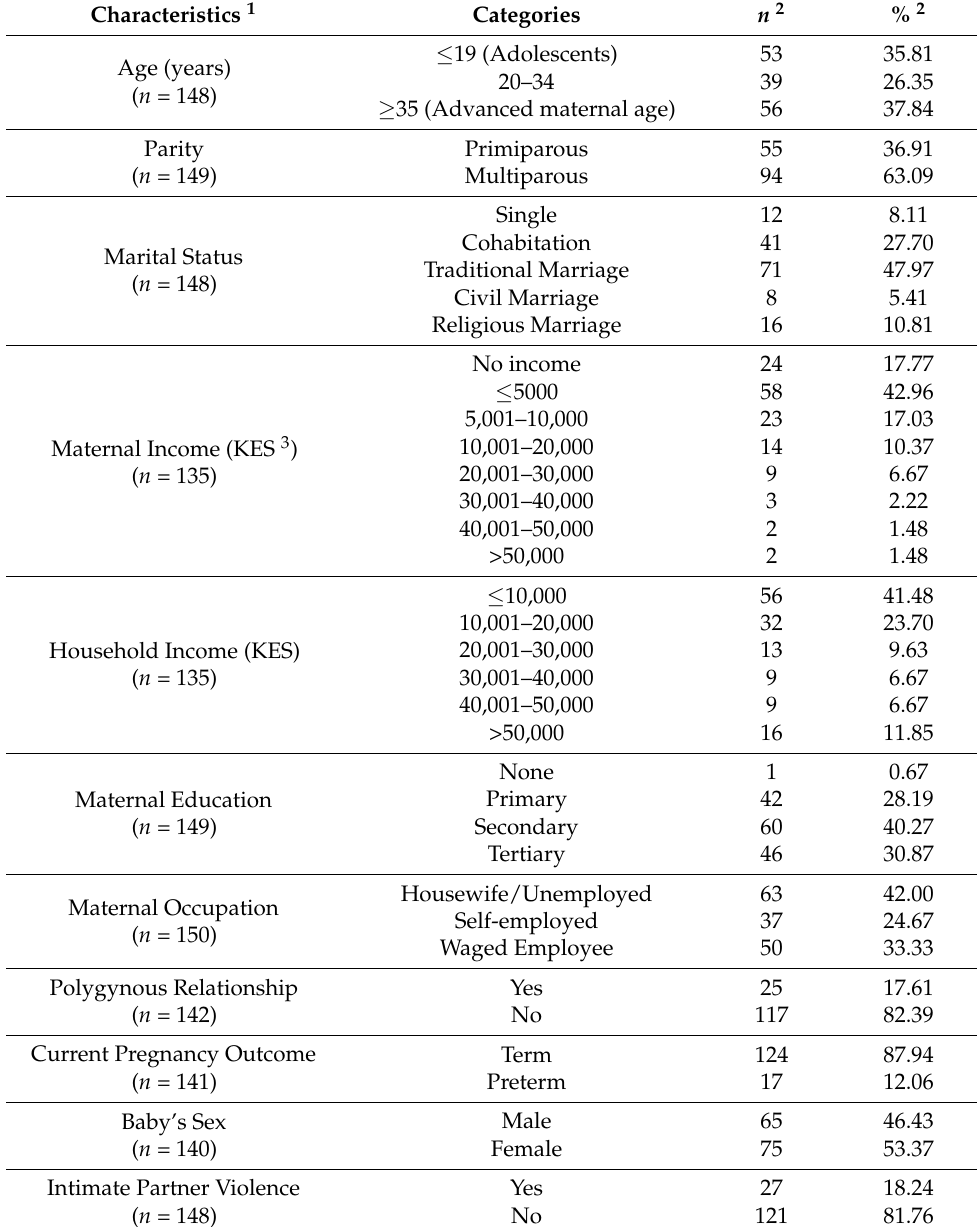
Table 2. Socio-demographic characteristics of study